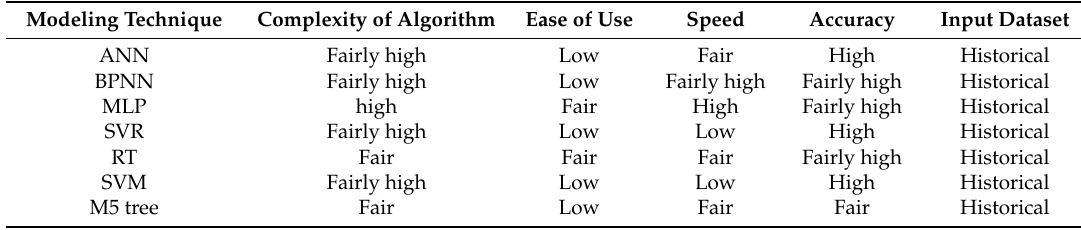
Table 5. Comparative analysis of single ML models for the prediction of long-term floods. Modeling Technique Complexity of